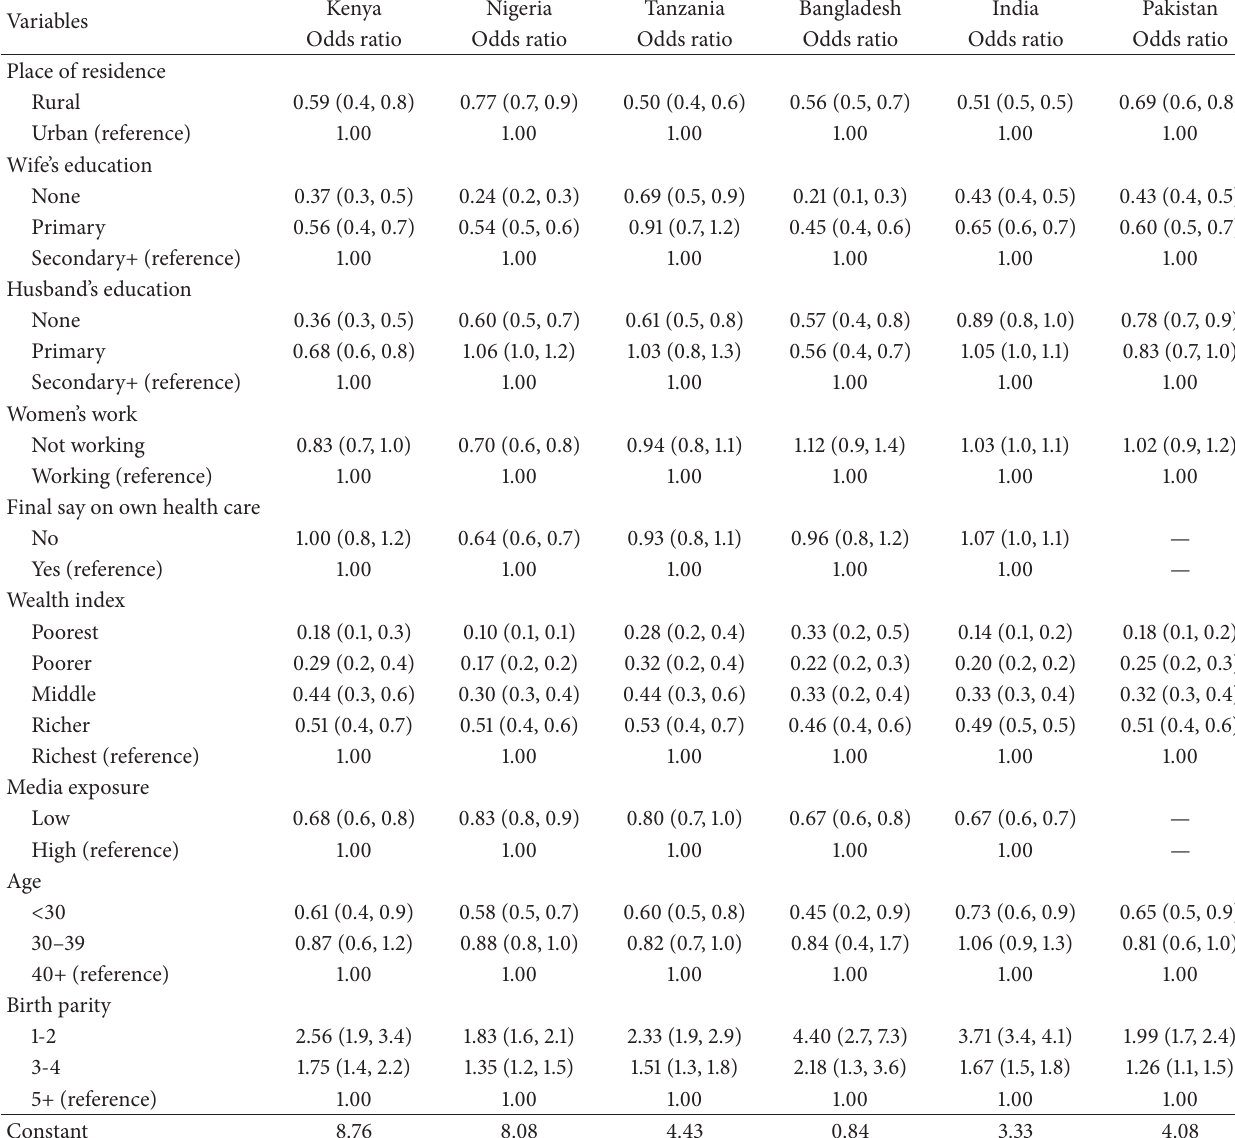
Figures in brackets show 95 percent confidence